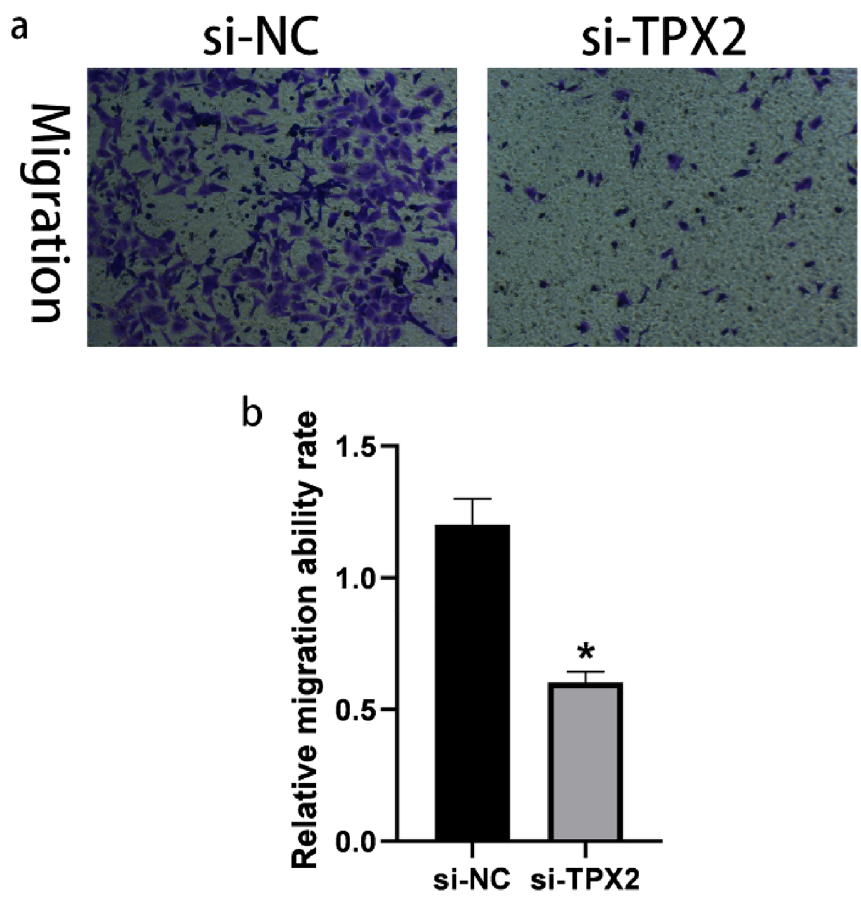
Figure 13. Transwell method to detect migration ability of si-NC group and si-TPX2 group. Silencing of TPX2 suppressed migration ability in A549 cells. ‘*’ represents P <